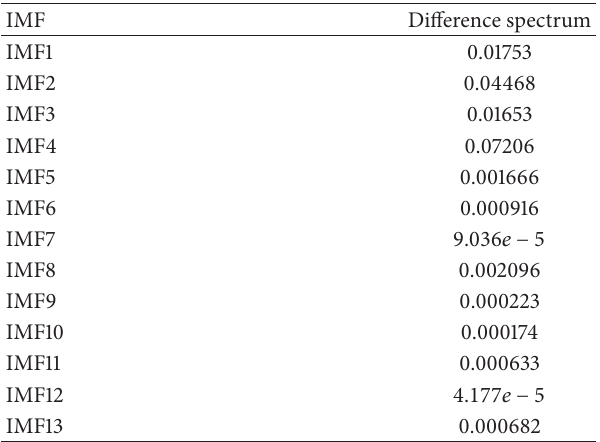
Table 1: The difference spectrum of the simulation signal corre- sponding to